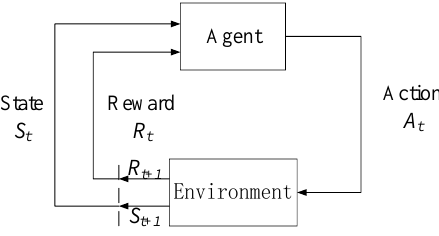
Figure 5. Q-learning logic block diagram.